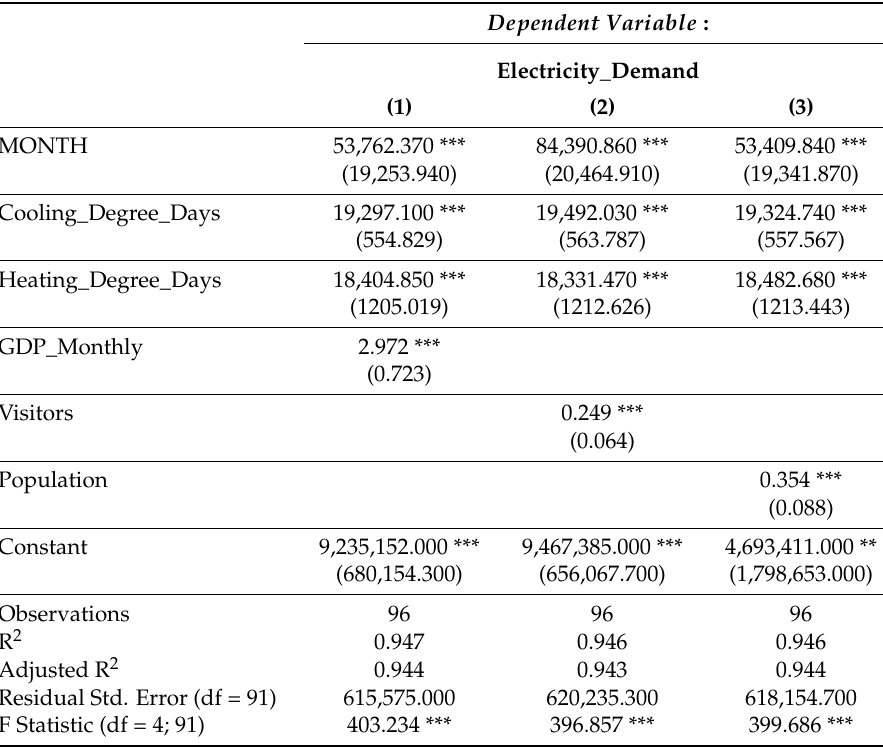
Table 2. Regression models.